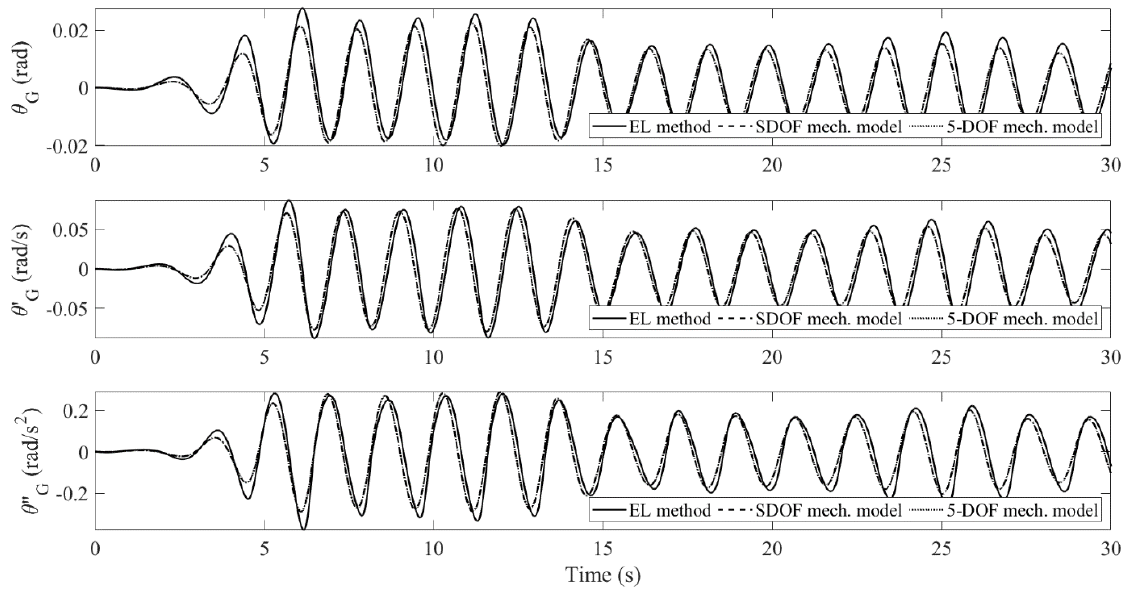
Figure 12. The pitch motion responses of the floating body, configured with a water tank installed with porous media, undergoing large wave excitation.